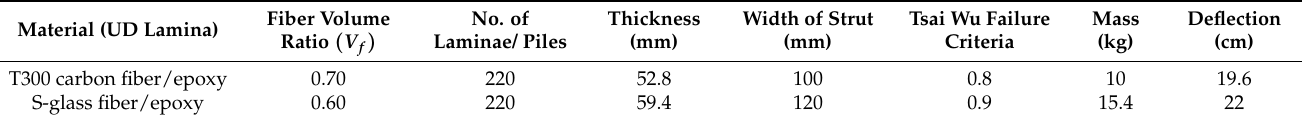
Table 10. Results of the landing gear assembly analysis under one point landing load condition.